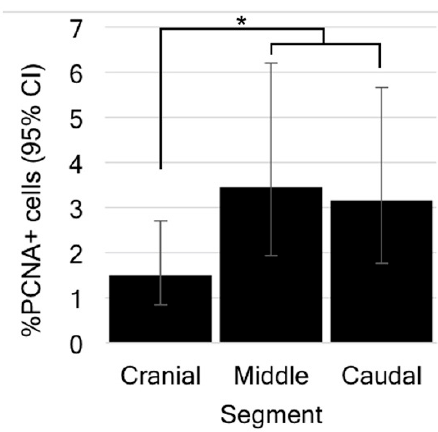
Figure 8. The proportion of PCNA+ cells varies along the length of the trunk spinal cord. Combining data across time points reveals a significantly reduced proportion of PCNA+ cells in the cranial segment of trunk spinal cord compared to the middle ( p = 0.0179) and caudal ( p = 0.0321) segments. CI = confidence interval. Asterisk (*) indicates significance ( p < 0.05).